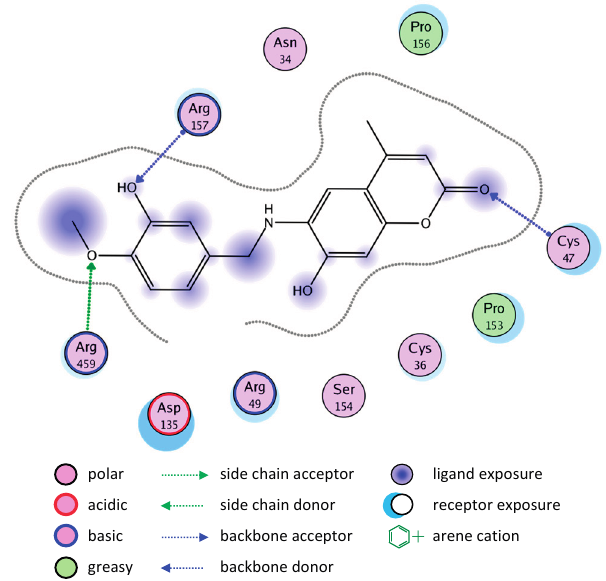
Figure 7. 2D representation of docking of compound 8 into the COX-1 active